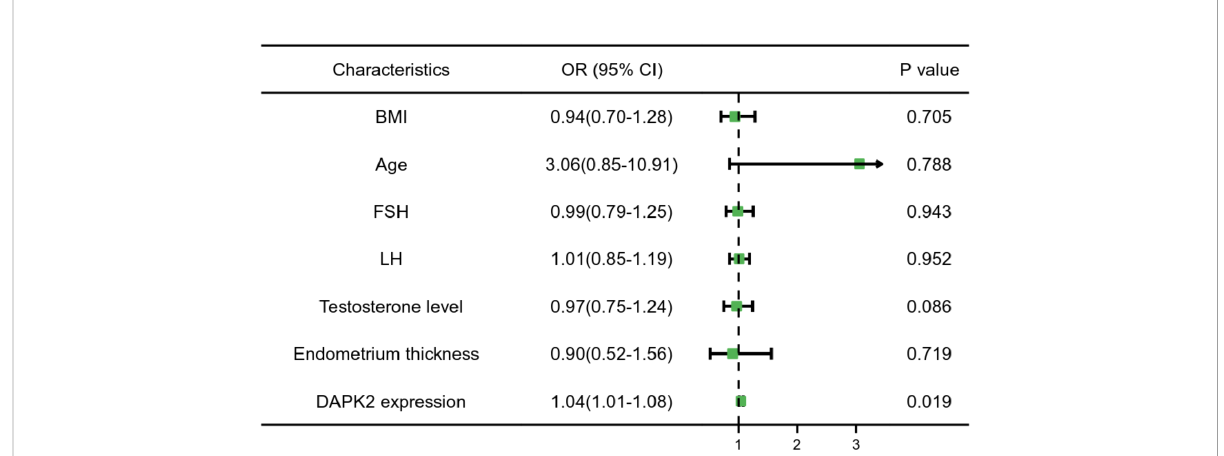
FIGURE 7 Forest plot for multivariable logistic regression analysis. P < 0.05 indicated that a factor is correlated with the implantation failure. OR > 1 indicated the factor was a high-risk factor. The expression of DAPK2 was observed to be an independent prognostic factor of implantation